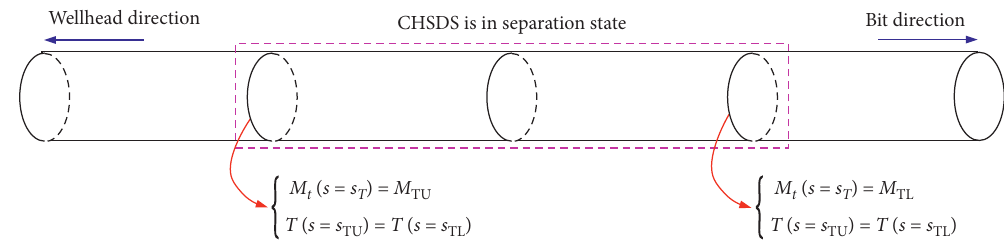
Figure 5: CHSDS separation state boundary